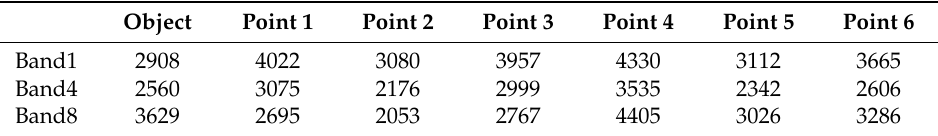
Table 1. Spectral values of object and pixels (three bands presented for example). The second column represents a single statistical value based on the multiple distinct spectral values of an object. The third to eighth columns represent spectral values of point1 to point6, respectively. The object and points refer to Figure 1.